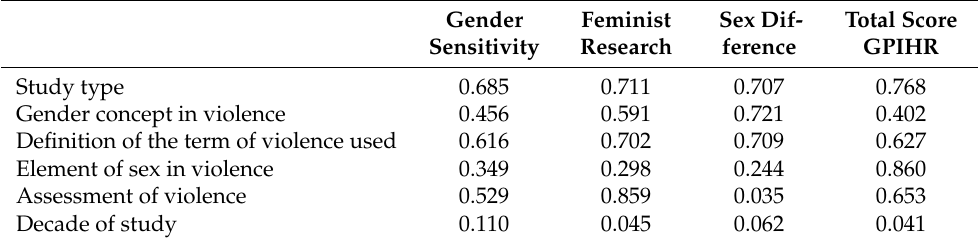
Table 3. Probability levels (p) associated with the Kruskal–Wallis